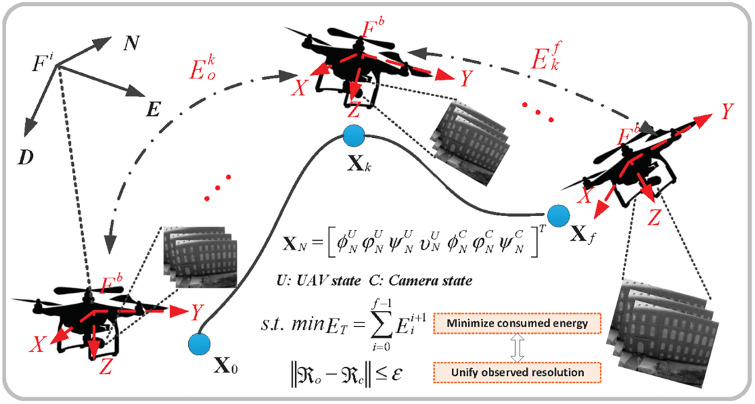
UAV flight control.